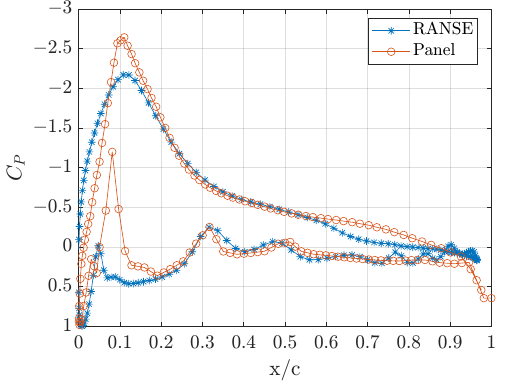
Figure 8. Resultant pressure coefficient along the chord of the center rib in the RANS and panel method solutions. The trim angles of attack in the RANS simulation and panel method are 12.4 de- grees and 14.8 degrees, respectively